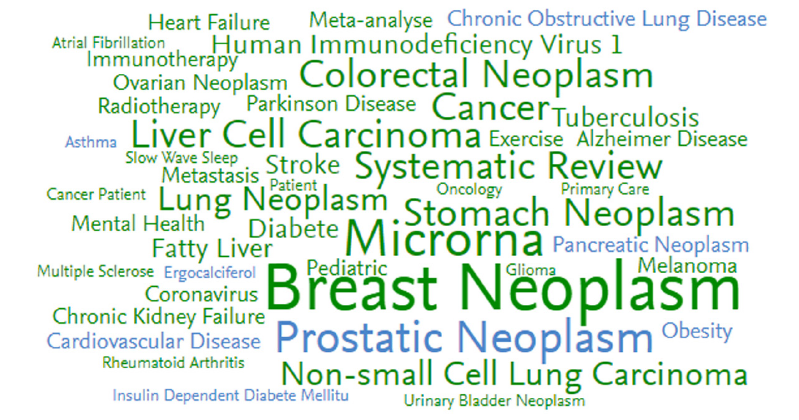
Figure 1. Results of the analysis of keyphrases for “SDG 3: good health and well-being” from 2015 to